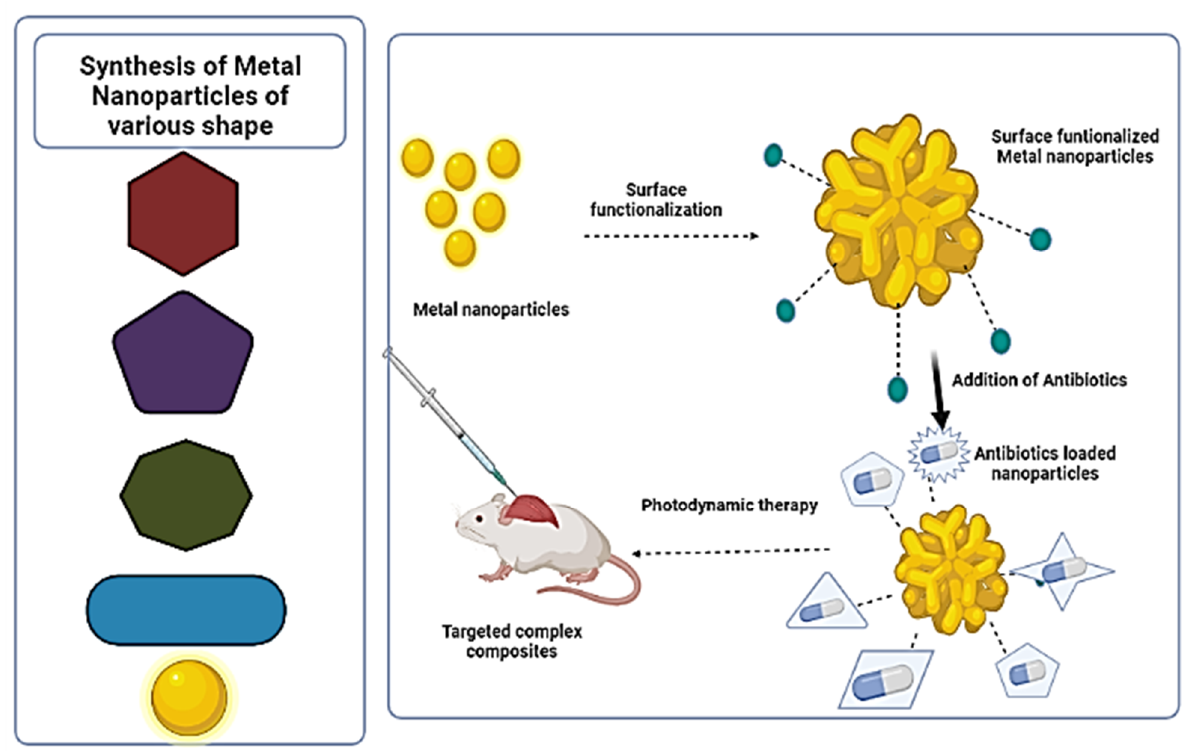
Figure 2. Different shape and size metal and metal oxide nanoparticles can be synthesized by different methods. This scheme represents surface functionalized by the different ligands, enzymes, polymeric components, which improves the binding sites of nanoparticles. Functionalized nanoparticles and antibiotic complex can be directly introduced to target test animal.